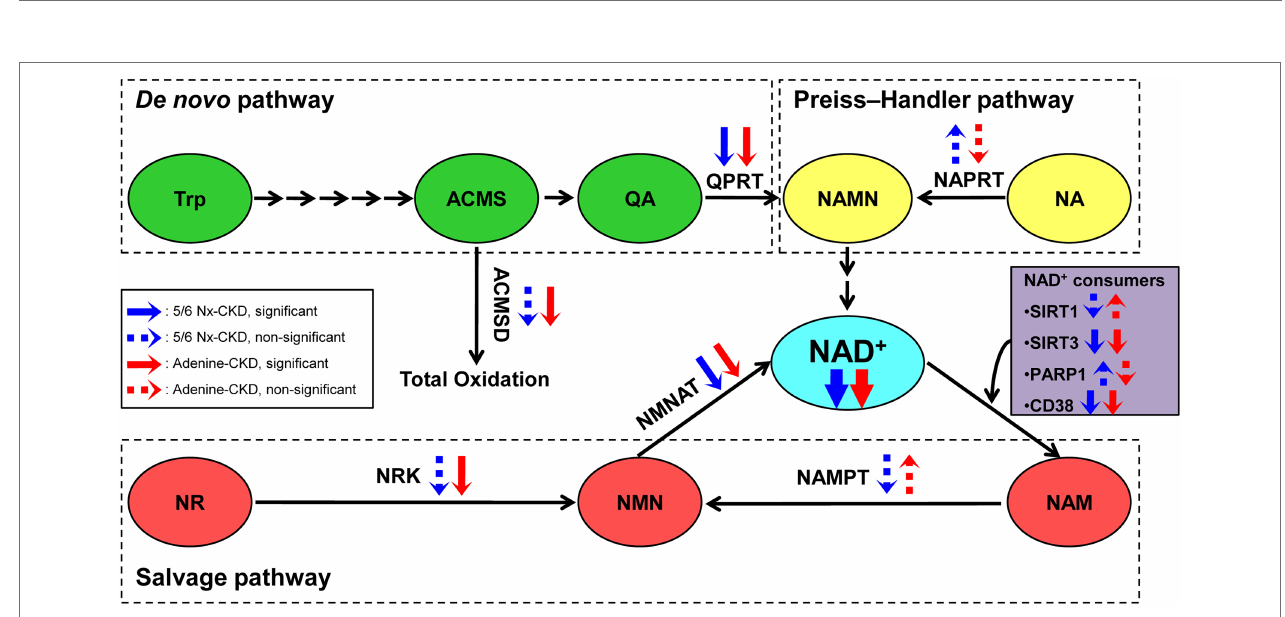
FIGURE 6 | The scheme summary of alterations in the three NAD + biosynthesis pathways in the setting of CKD. ACMS, α -amino- β -carboxymuconate- ε - semialdehyde; ACMSD, α -amino- β -carboxymuconate- ε -semialdehyde decarboxylase; NA, nicotinic acid; NAD, nicotinamide adenine dinucleotide; NAM, nicotinamide; NAMN, nicotinic acid mononucleotide; NAMPT, nicotinamide phosphoribosyltransferase; NAPRT, nicotinic acid phosphoribosyltransferase; NMN, nicotinamide mononucleotide; NMNAT, nicotinamide mononucleotide adenylyltransferase; NR, nicotinamide riboside; NRK, nicotinamide riboside kinase; PARP1, poly (ADP-ribose) polymerase 1; QA, quinolinic acid; QPRT, quinolinic acid phosphoribosyltransferase; SIRT1, sirtuin 1; SIRT3, sirtuin 3; and Trp,